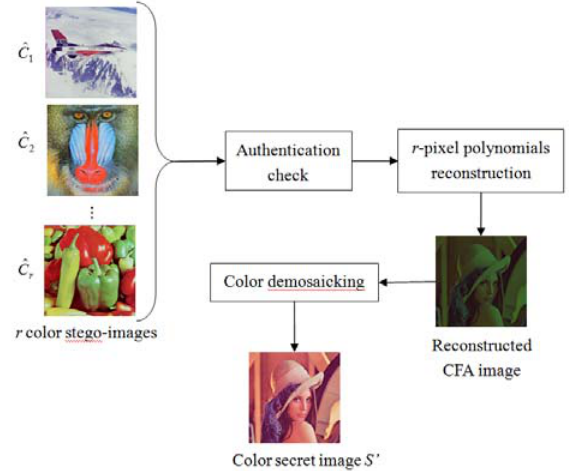
Fig. 6. Block diagram of the proposed CFA color secret image revealing